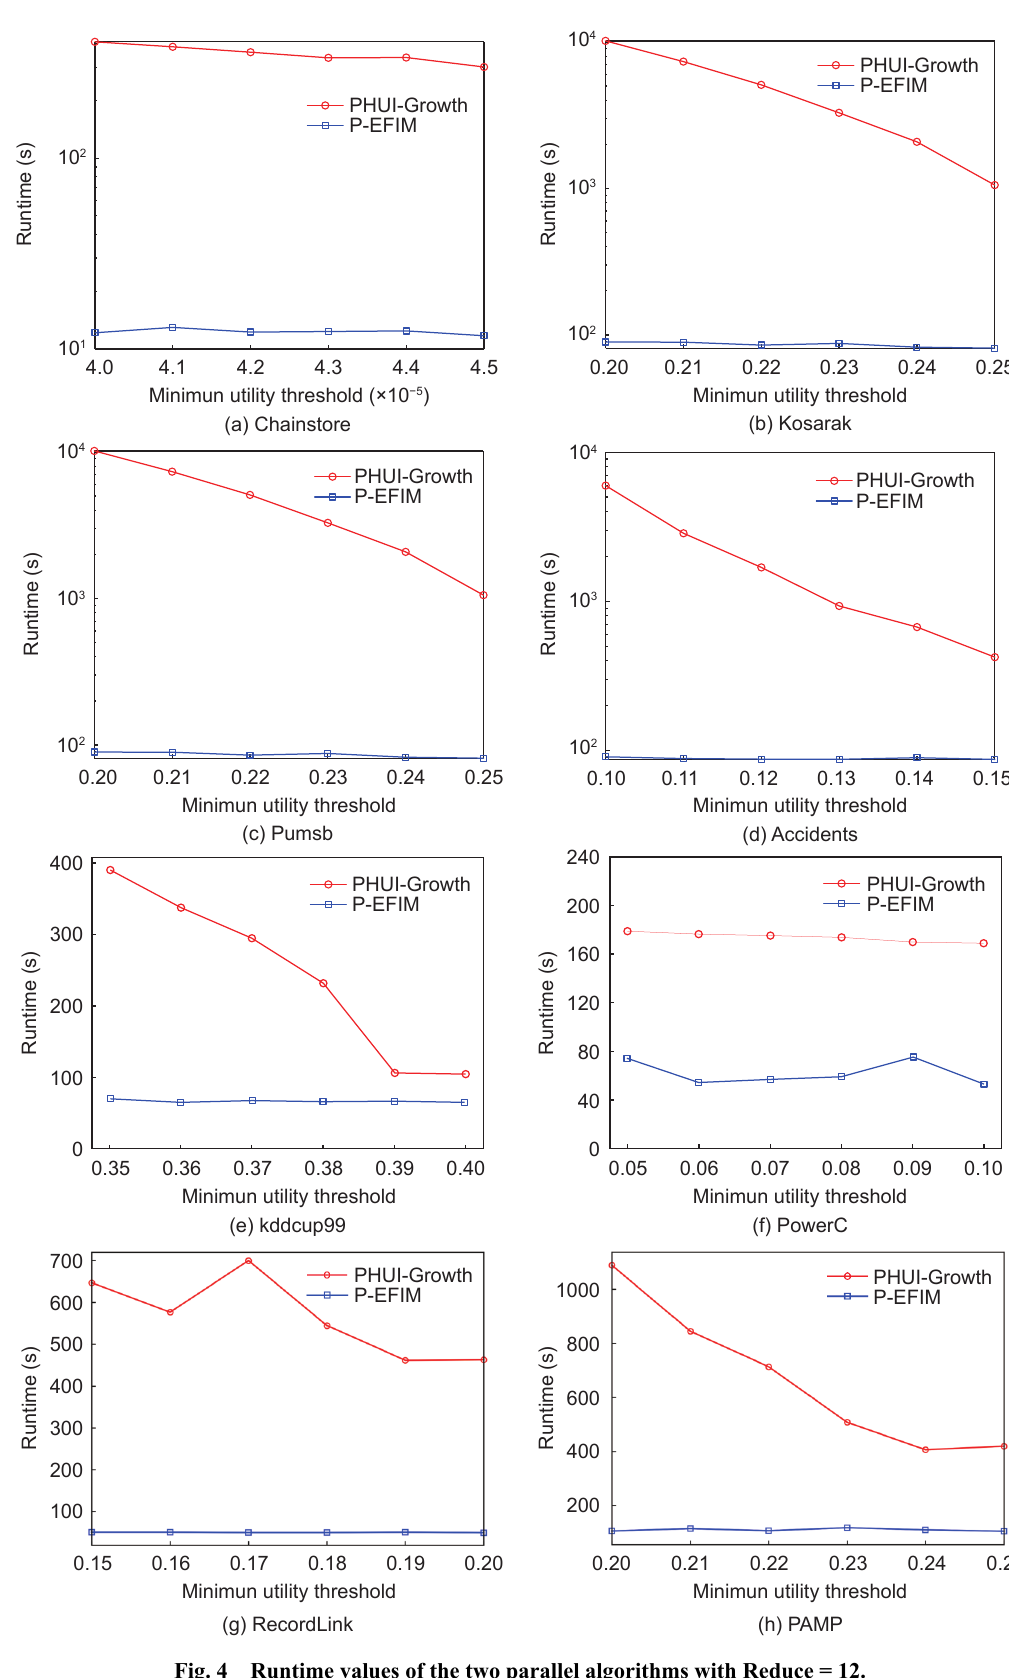
Fig. 4 Runtime values of the two parallel algorithms with Reduce =